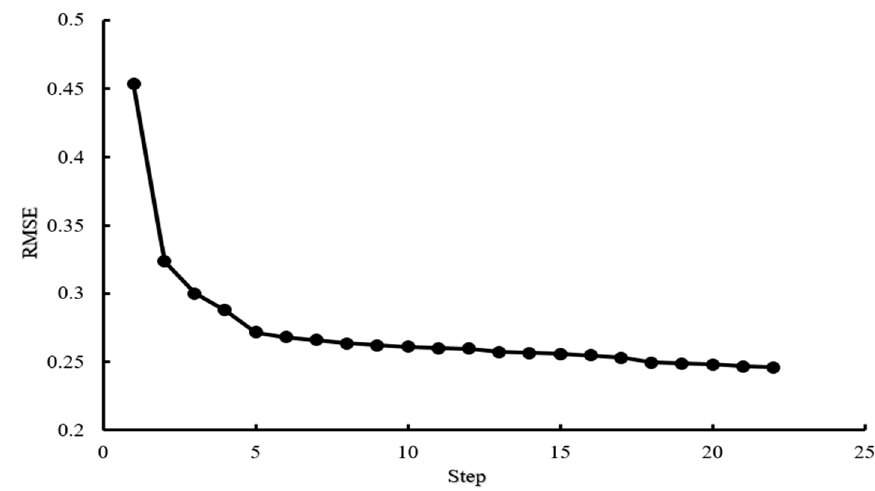
Figure 9. Iterative root mean square error change trend graph.